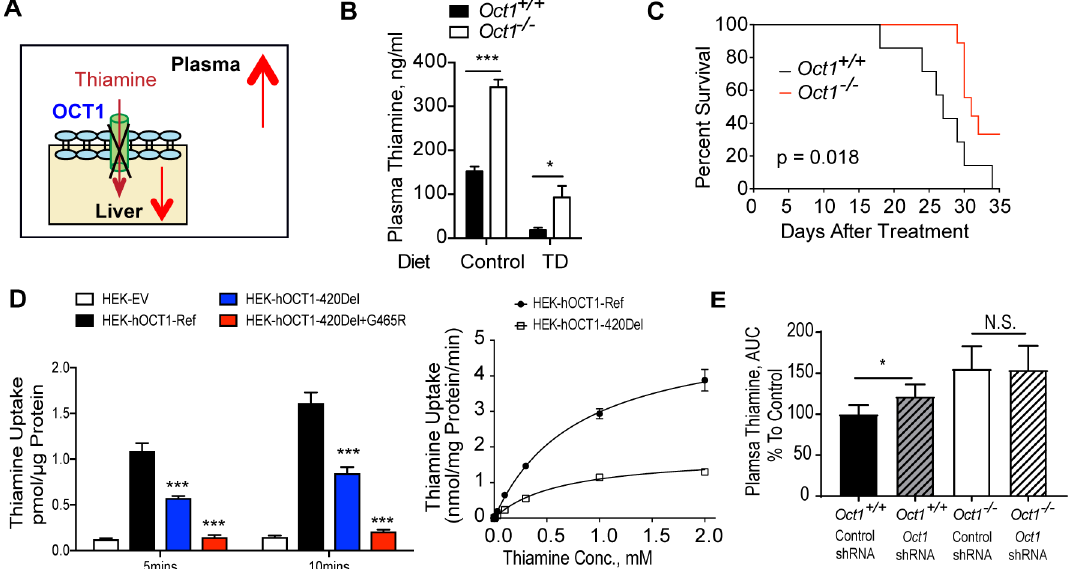
Fig 3. Oct1 function modulated thiamine disposition in vivo and in vitro. (A) Scheme: deletion of Oct1 reduces hepatic uptake of thiamine and increases plasma thiamine levels. (B) Plasma thiamine levels ( n = 6 per genotype on a control diet; n = 7 per genotype on a TD). (C) Survival curves for mice on TDs ( n = 7 for Oct1 +/+ mice and n = 9 for Oct1 -/- mice). Animals were euthanized once the humane end points (body condition score of 2 or less or 15% body weight loss) were reached during the treatment (Gehan-Breslow- Wilcoxon test and log-rank test were used for analysis). (D) Representative graph of thiamine uptake in cells stably expressing EV, hOCT1-Ref, hOCT1-420Del, and hOCT1-420Del+G465R; a total of 25 nM thiamine was included in the uptake buffer. Representative graph of thiamine kinetics in cells expressing hOCT1-Ref and hOCT1-420Del; concentrations ranged from 25 nM to 2 mM; uptake was performed for 4 minutes. n = 3 replicated wells; two separate experiments were performed for the in vitro studies. (E) The area under the plasma concentration-time curve of thiamine. A single intraperitoneal injection of 2 mg/kg thiamine (with 4% 3 H-thiamine) was administered to four groups of mice ( Oct1 +/+ mice treated with control shRNA, n = 6; Oct1 +/+ mice treated with Oct1 shRNA, n = 6; Oct1 -/- mice treated with control shRNA, n = 3 and Oct1 -/- mice treated with Oct1 shRNA, n = 3) Data are normalized to Oct1 +/+ mice treated with control shRNA. Data shown are mean ± SEM. Data were analyzed by unpaired two-tailed Student t test; (cid:3) p < 0.05, (cid:3)(cid:3) p < 0.01, and (cid:3)(cid:3)(cid:3) p < 0.001. Underlying data are provided in S1 Data. AUC, area under the curve; EV, empty vector; hOCT1-Ref, human OCT1 reference; hOCT1-420Del, human OCT1 with methinone 420 deletion; hOCT1-420Del+G465R, human OCT1 with mutation in glycine 465 -to-arginine in addition to 420Del; Oct1 ,organic cation transporter 1; shRNA, short hairpin RNA; TD, thiamine deficient diet.